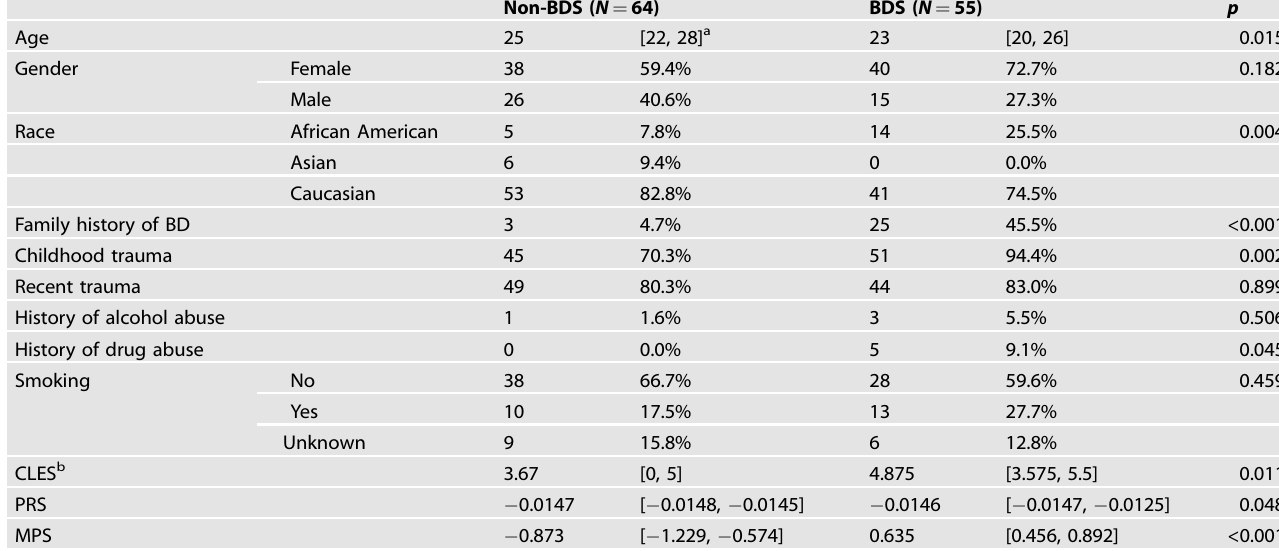
Table 1. Demographics and illness characteristics of study subjects.